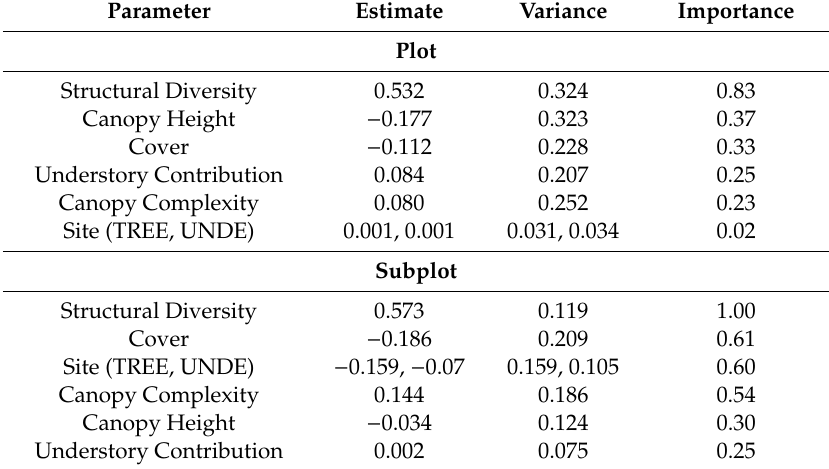
Table 4. Table of parameter contributions to models ranked by weighted importance of the parameter, with the standardized average parameter estimate across all models to which the parameter contributed (Estimate), thestandardizedvarianceoftheestimatedparameter(Variance), andtheweightedimportance of the parameter (Importance) for both scales [34]. Estimates and variances were standardized around the standard deviation of the variable. The site variable, because it was categorical, was treated as an indicator variable, and thus the parameter estimates for TREE and UNDE are relative to CNNF